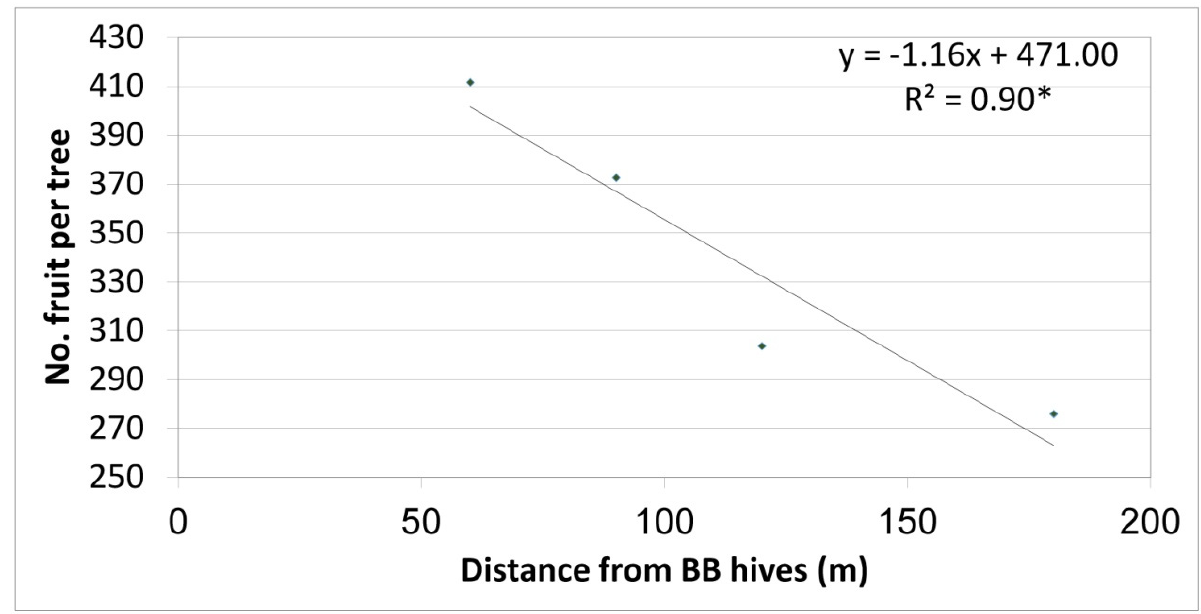
Figure 3. Relationship between row distance from bumblebee (BB) hives and the number of fruit per ‘Hass’ tree, Kfar Giladi, 2017/18. Each data point is an average of five trees, * p < 0.05.